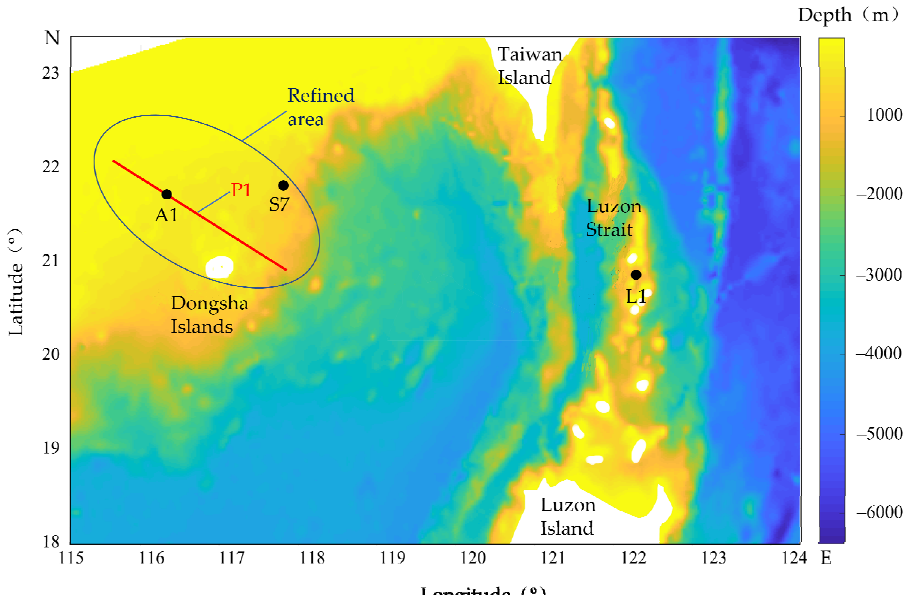
Figure 1. Sketch of the computation domain.